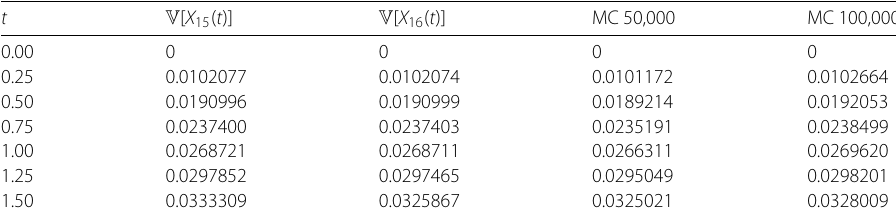
Table 11 Approximation of the variance of the solution stochastic process. Example